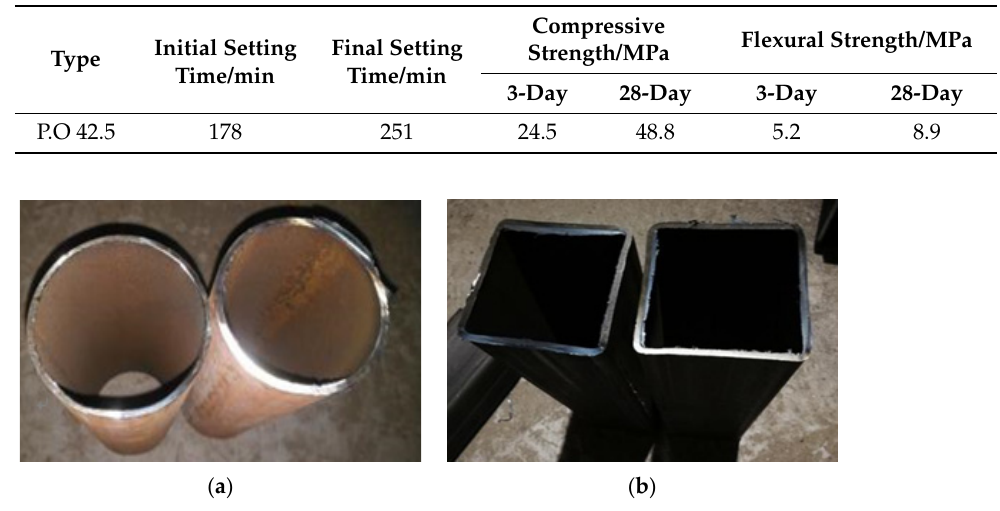
Table 1. Performance of cement.